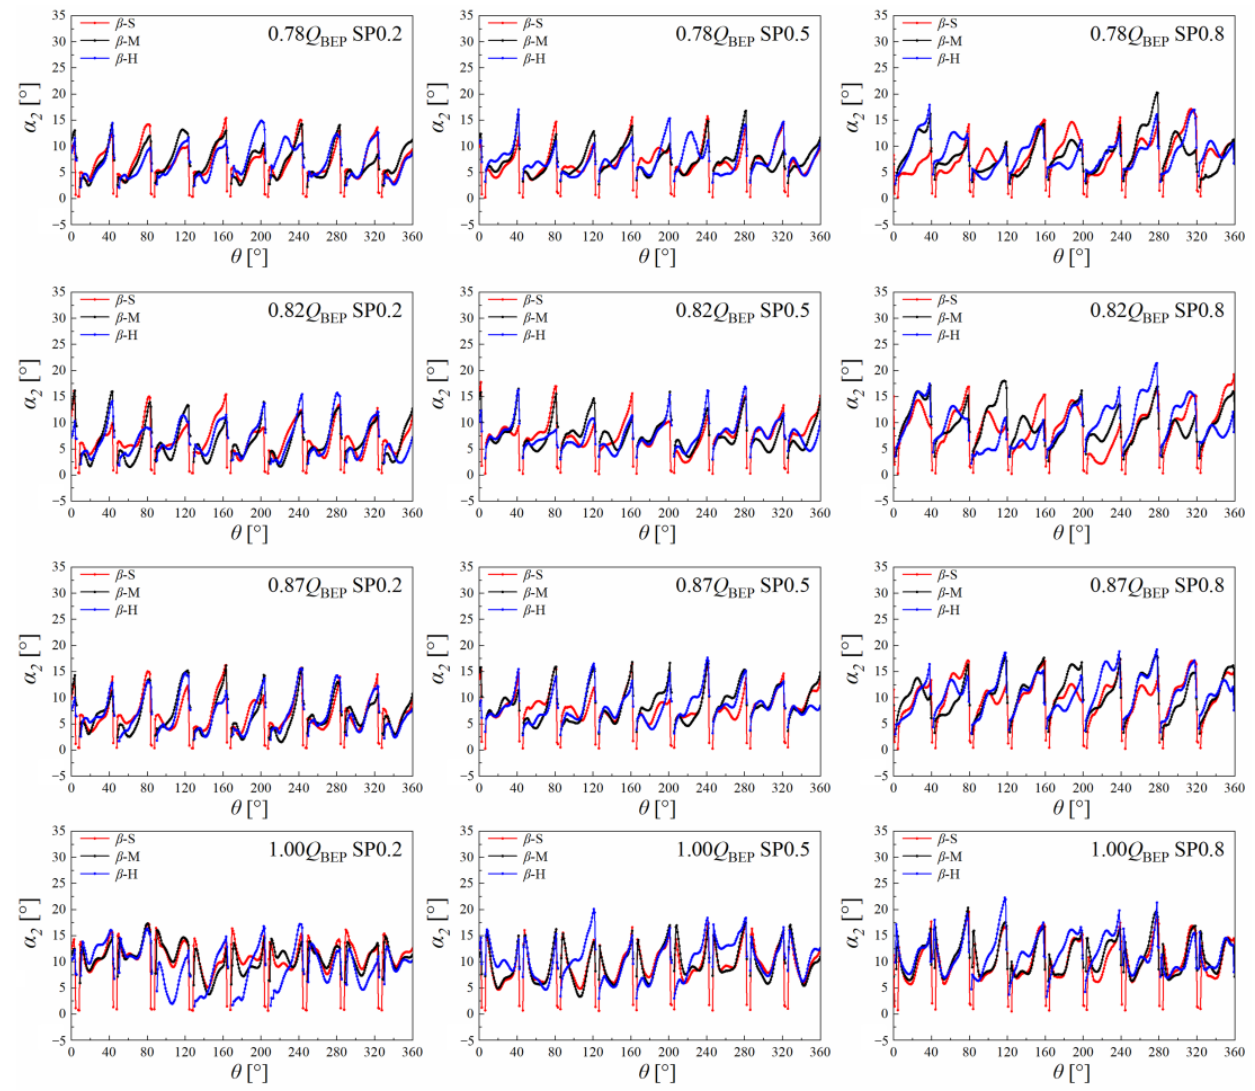
Figure 12. Distributions of absolute flow angle α 2 at the runner outlet in the circumferential direction.